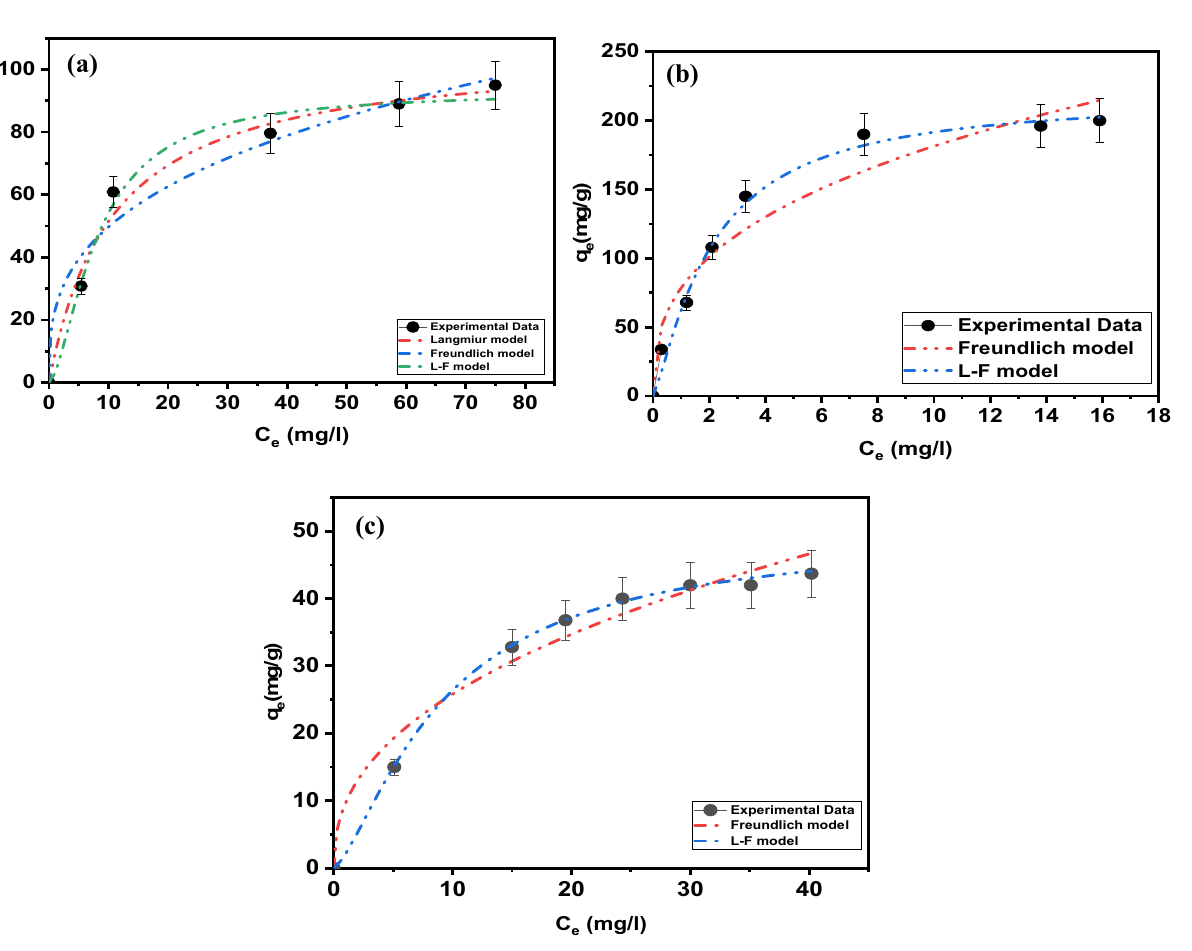
Figure 14. Experimental adsorption isotherm data from the ternary system for ( a ) MB and ( b ) MO and MG dyes on the LDH fitted using the two-parameter